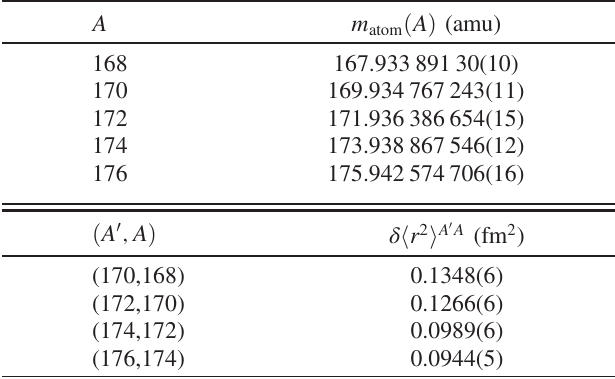
TABLE VI. Atomic masses and differences in mean-square nuclear charge radii. These values are respectively given by Ref. [54] and Ref. [24].